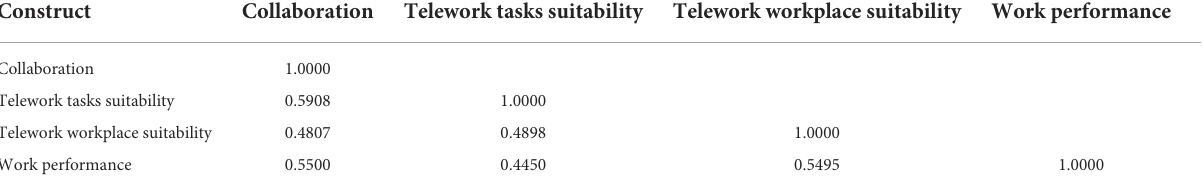
TABLE 3 Construct correlation